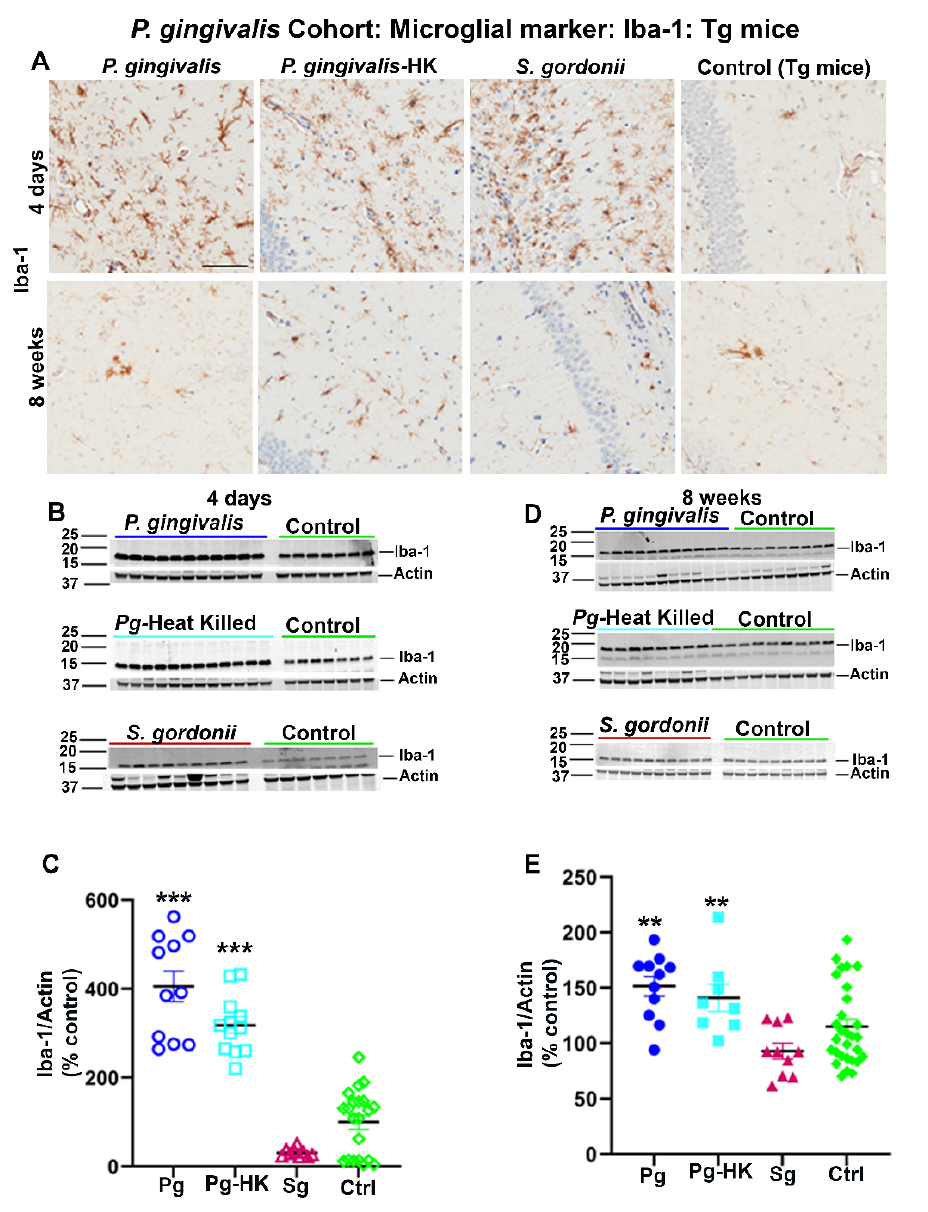
Figure 4. Immunostaining of the Tg mice brains intracerebrally infected (4 days and 8 weeks) with P. gingivalis , HK P. gingivalis , and S. gordonii induced microgliosis: P. gingivalis cohort. ( A ) Repre- sentative brain sections of the Tg mice infected with P. gingivalis , HK P. gingivalis, S. gordonii , and sham-infected Tg mice were immunostained for microglial marker Iba-1 euthanized at 4 days and 8 weeks post-infection. (Scale bar-300 µ m). B & D Immunoblots of Tg mice intracerebral-infected with bacteria and sham-infected Tg mice brain homogenate was probed with a polyclonal anti-Iba-1 antibody at 4 days ( B ) and 8 weeks ( D ) post-infections. C & E Intensity analysis of immunoreactive bands of interest were normalized to β -actin. Microglial marker Iba-1 was significantly increased in P. gingivalis , HK P. gingivalis , and S. gordonii -infected Tg mice compared to the sham–infected Tg mice after 4 days of infection ( C ). Similarly, Iba-1 was also significantly increased in P. gingivalis , and HK P. gingivalis infected Tg mice compared to the sham–infected Tg mice after 8 weeks of infection ( E ). Data represent as mean ± SEM (** p < 0.05; *** p < 0.001; Multiple t -test; n =